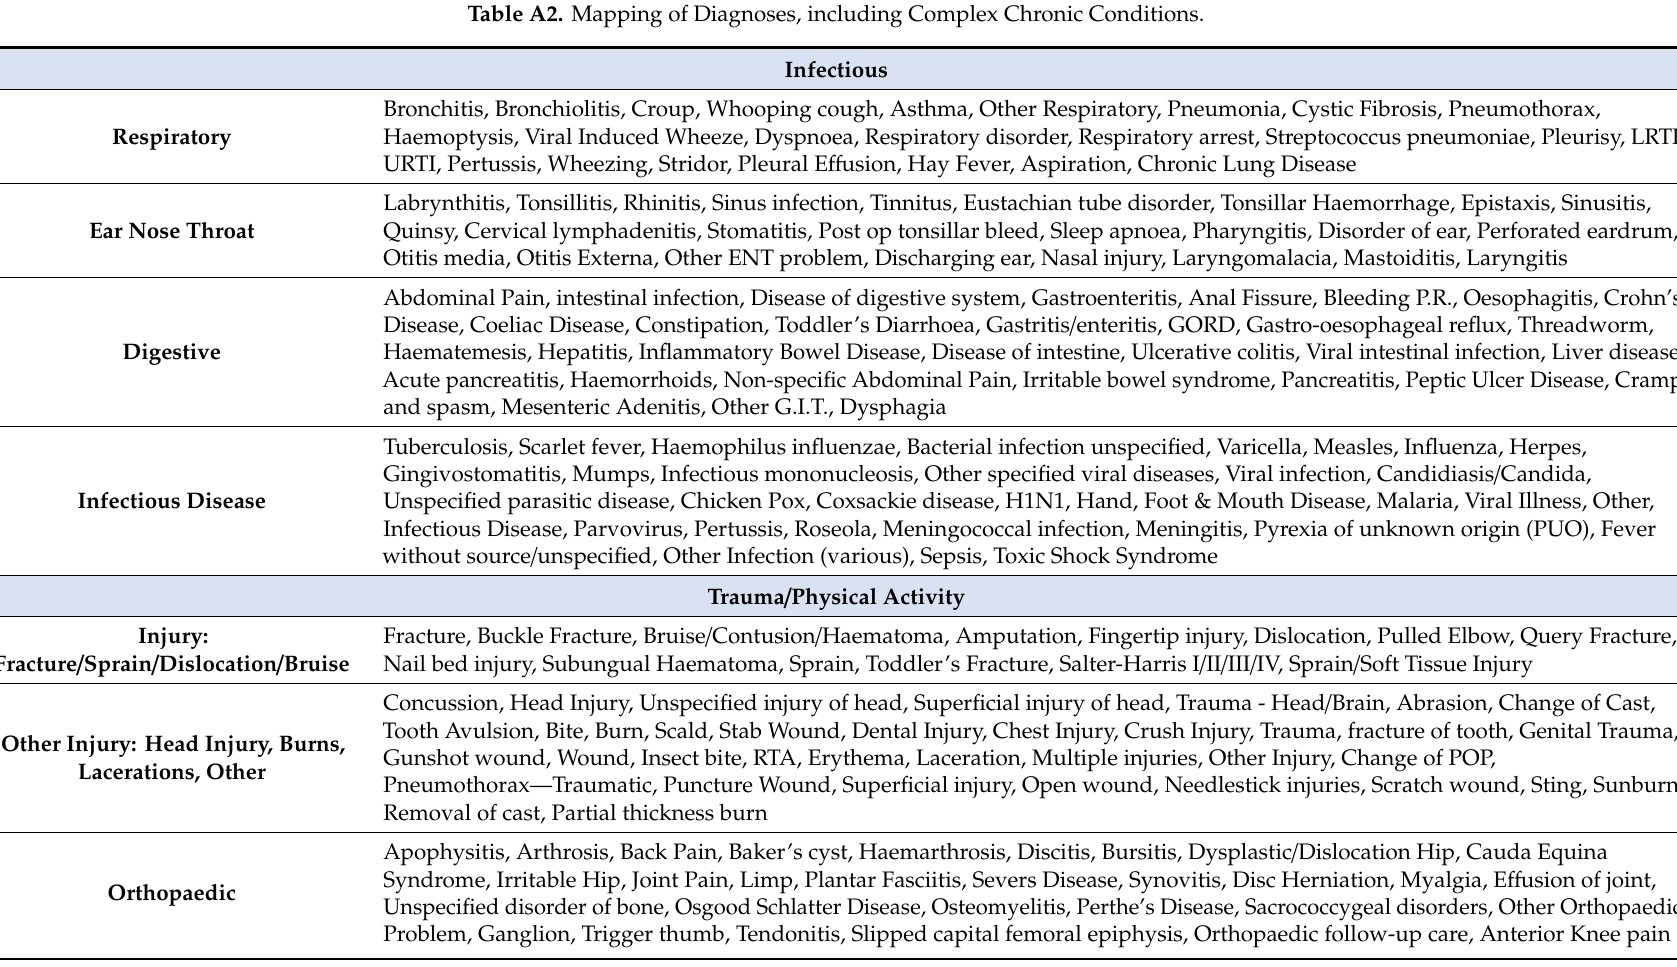
Table A2. Mapping of Diagnoses, including Complex Chronic